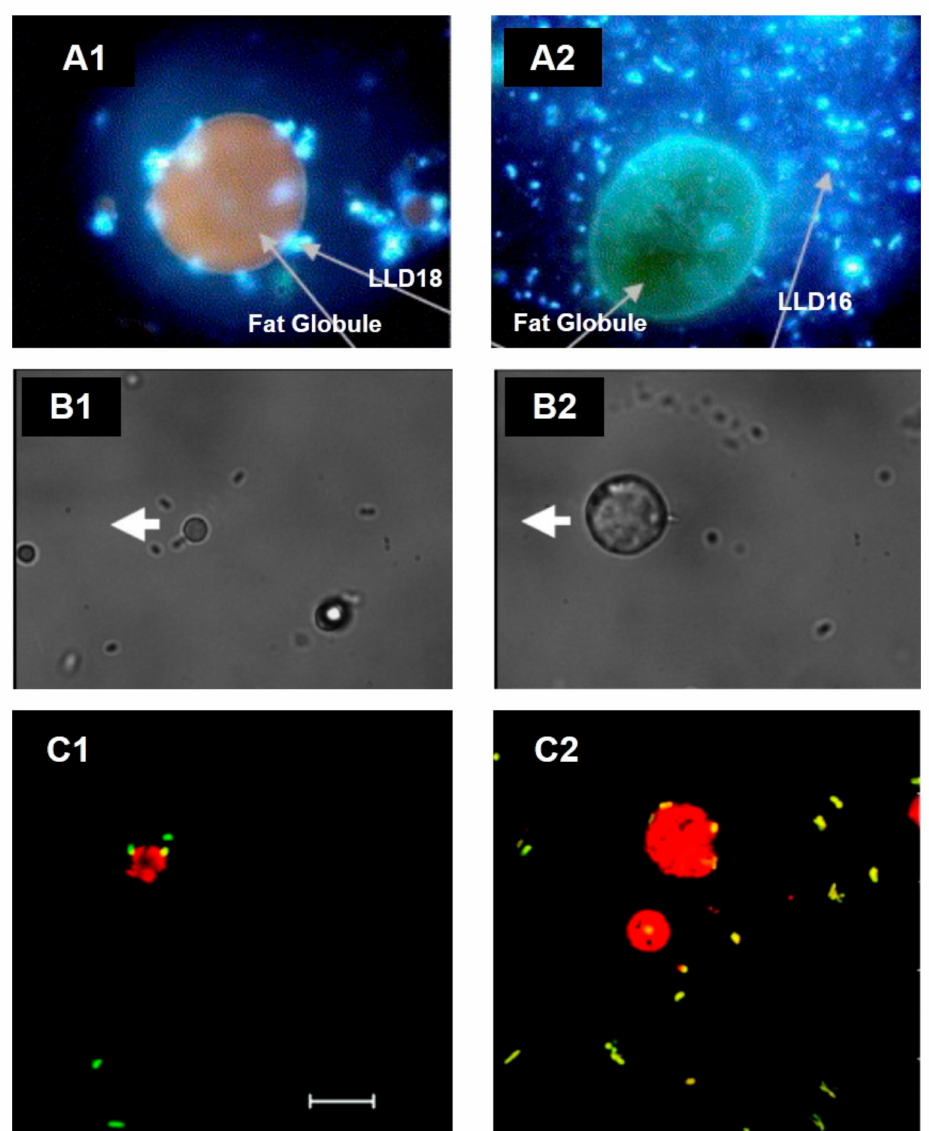
Figure 3. Association of lactic acid bacteria (LAB) with the MFGM in cream imaged by microscopy. ( A ) Fluorescence microscopy images of L. lactis ssp. lactis subv. Diacetylactis. ( A1 ) Variant 18 (LLD18) is clearly attached to the MFGM, whereas ( A2 ) variant 16 (LLD16), in comparison, is not. Adapted with permission from Ly et al. (2006) Copyright 2006 Elsevier Ltd. [74]. ( B ) Optical tweezer force images of L. reuteri SD2112 attached to the MFGM. ( B1 ) Bacterial cells fixed to the cover slide, whereas ( B2 ) shows the experiment when the MFGM is attached to the cover slide. The thick white arrow shows the direction of the microscope stage travel. Adapted with permission from Brisson et al. (2010). Copyright 2010 American Chemical Society [75]. ( C ) Confocal laser scanning images of ( C1 ) L. reuteri SD2112 and ( C2 ) L. reuteri T-1 in raw cream. Scale bar = 10 µ m. Adapted with permission from Brisson et al. (2010). Copyright 2010 American Chemical Society